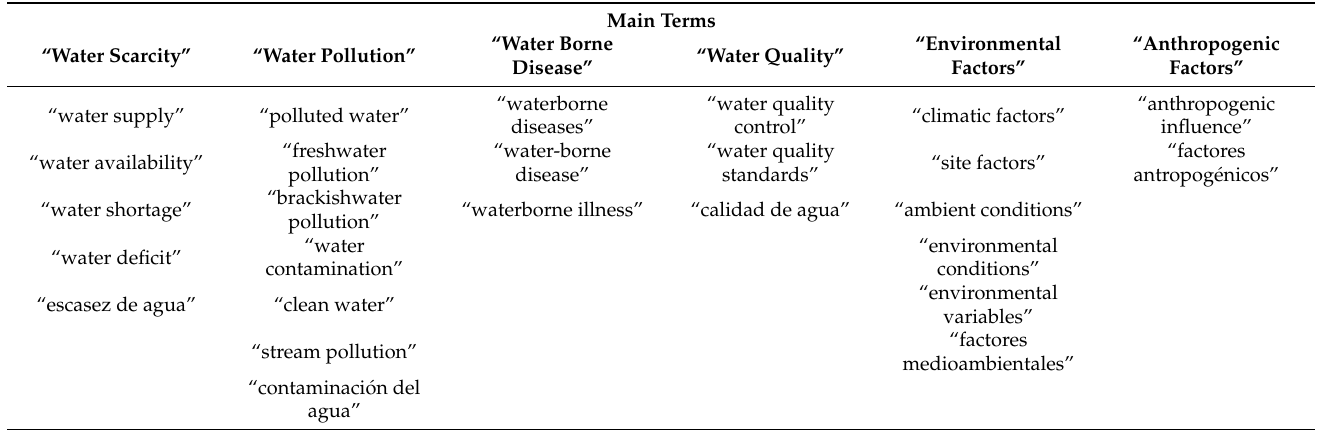
Table A1. Main terms and related terms according to thesaurus functions.